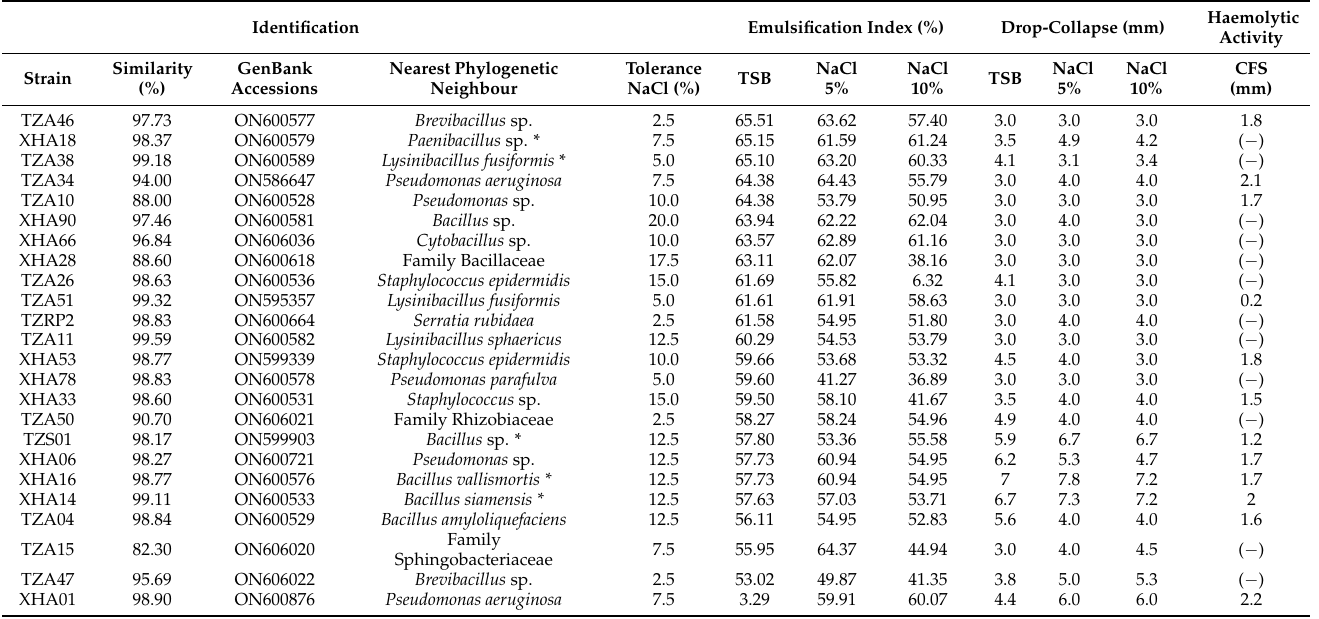
Table 2. Taxonomy of bacteria strains from two pristine sinkholes of the Yucatan Peninsula selected for their BS and BE activity stable under salinity conditions, NaCl tolerance and haemolytic